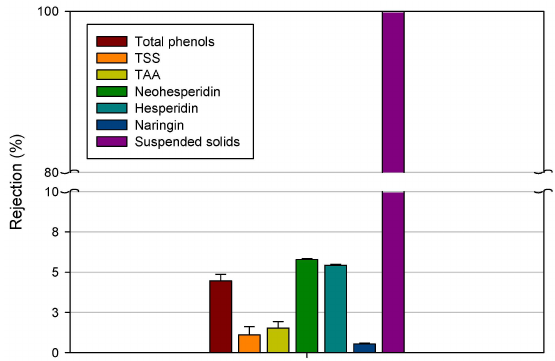
Figure 5. Rejection of PVDF HF membranes towards investigated compounds of orange press